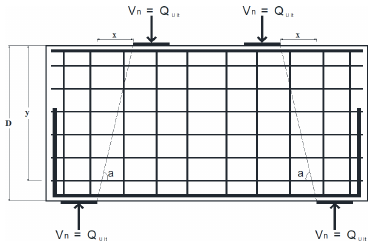
Figure 21: Natural load paths joining the loading and reaction